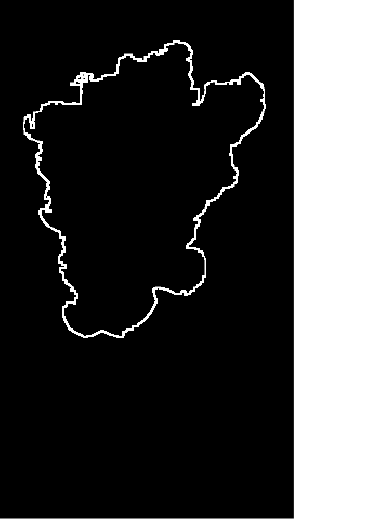
Figure 17. The contour of the front cluster. ( a ) Contour of the front cluster, and ( b ) contour of front cluster in RGB image.